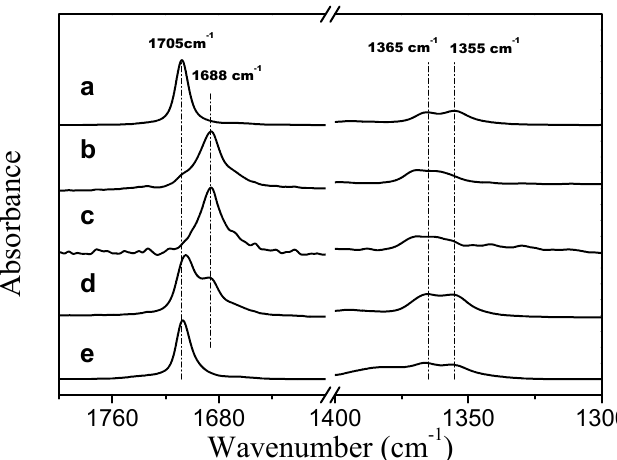
Figure 7. Corrected ATR FTIR spectra of TMBK at a temperature of 301 K ( a ); TBMK in D 2 O at a concentration of 5 wt % and a temperature 278 K ( b ); TBMK in D 2 O at a concentration of 5 wt % and a temperature 301 K ( c ); PVME/TBMK/D 2 O at c P = 0.5 wt % and c ad = 5 wt % and a temperature of 278 K ( d ); and PVME/TBMK/D 2 O at c P = 0.5 wt % and c ad = 5 wt % and a temperature of 301 K ( e ).